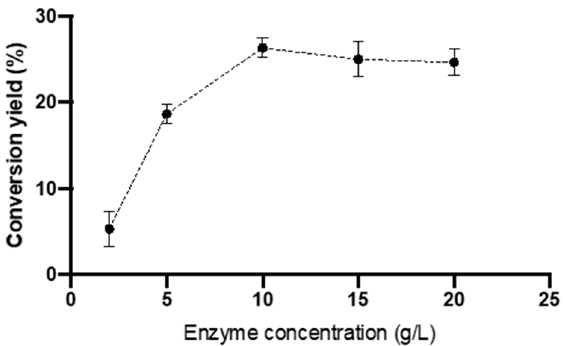
Figure 1. Effect of enzyme concentration on the conversion yield of IBU-sorbitol ester catalyzed by PPL. Reaction time: 15 h (equilibrium condition). All measurements were performed in triplicate.